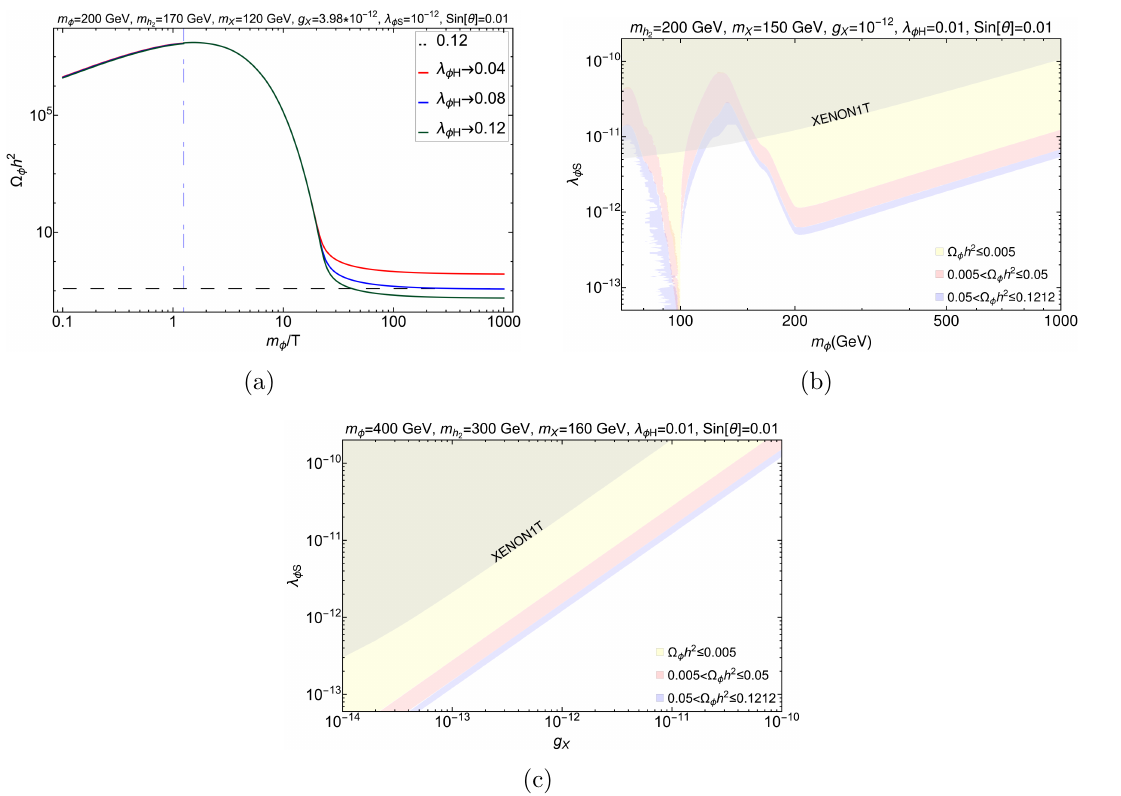
Figure 20 . Figure 20(a) shows freeze-out pattern for WIMP ( φ ) relic density as a function of m φ /T for some fixed values of λ φH , which also ensures freeze-out aEWSB. The vertical dot-dashed line corresponding to EWSB ( x EW ). Figure 20(b) denotes a correlation plot for the under-abundant φ in m φ − λ φS plane. The constraints from spin independent DD cross-section obtained from XENON1T data are shown in grey shades. The parameters kept fixed for are mentioned in figure heading. The colour shades in light blue, light red and light yellow show the ranges of under abundance as mentioned in figure inset. In figure 20(c), we show the under abundant φ in λ φS vs. g X